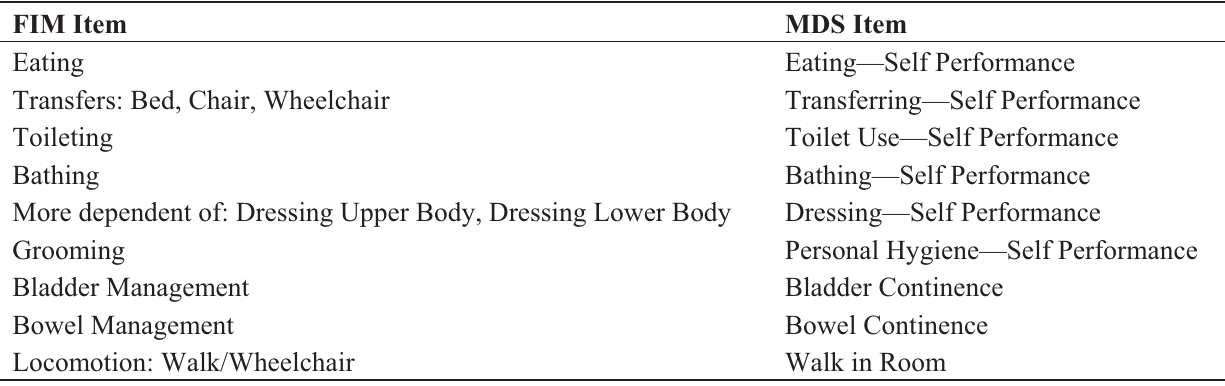
Table 1. Alignment of Functional Independence Measure (FIM) and MDS Items Used by Williams and